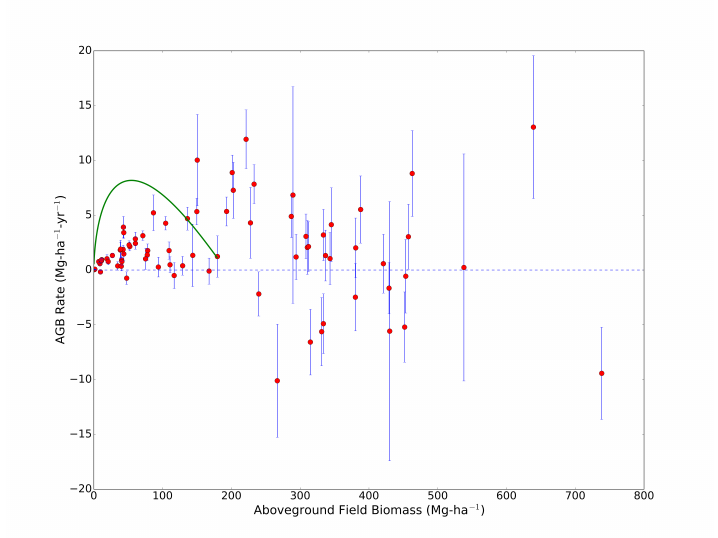
Figure 10. The AGB rates estimated from the phase-height rates multiplied by the conversion factor in (12), plotted against AGB. The green curve is the site-specific, stand-level growth model of Neeff and Santos [31] based on field data at Tapajo´s.